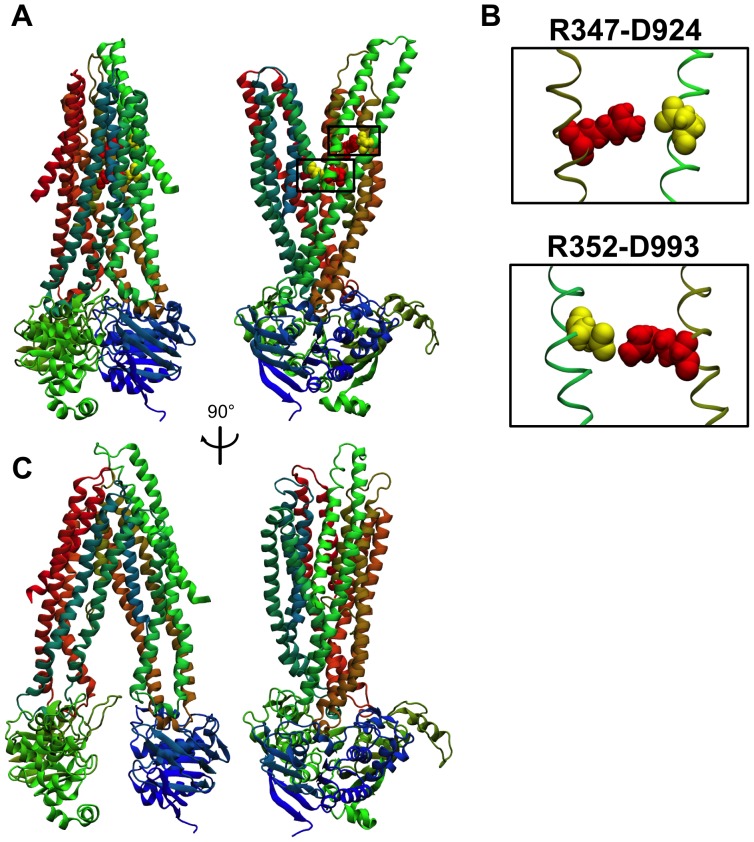
New open- and closed-state models.A: Front and side views of a ribbon representation of the O-CFTR homology model based on the Sav1866 crystal structure template. Residues are assigned colors as follows: MSD1 is colored red-orange; NBD1 green; MSD2 blue-green; and NBD2 blue. We note tight dimerization between the two NBDs, and a separation in the two “wings” of the MSDs in the transmembrane and extracellular regions. B: Close-ups of the residue pairs R347-D924 and R352-D993. The current model agrees with experimental data on salt bridge interactions between the arginine (red spheres) and aspartate (yellow spheres) residues in each of these pairs. Side chain distances between guanidinium N and carboxyl O atoms in these pairs are 4.6 Å (R347-D924) and 3.7 Å (R352-D993), respectively. C: Front and side views of a ribbon representation of the C0-CFTR model based on the P-gp crystal structure template. The same coloring scheme as in part A was followed. In this model, the NBDs are widely separated, with no separation of the “wings” in the extracellular region that constitutes a gate to ion conduction. A wide cytosolic vestibule could allow binding of large pore blockers as well as large substrates such as glutathione.